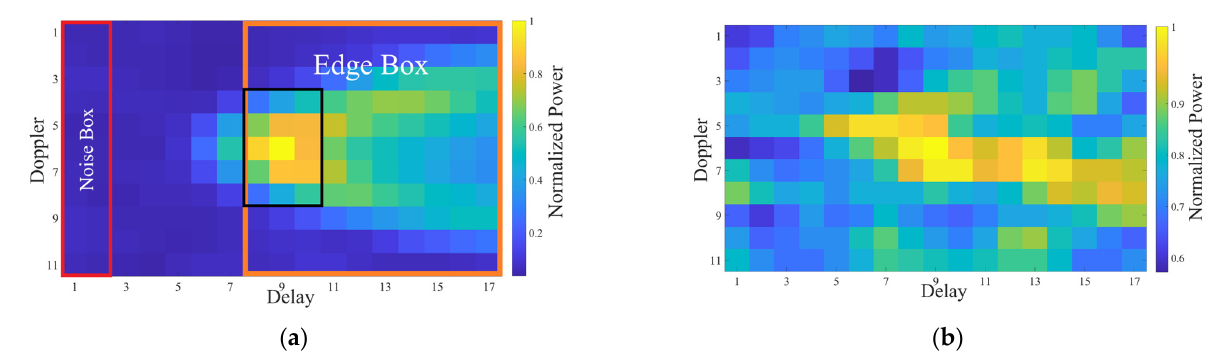
Figure 6. ( a ) DDM with a distinct horseshoe shape, ( b ) DDM without a distinct horseshoe